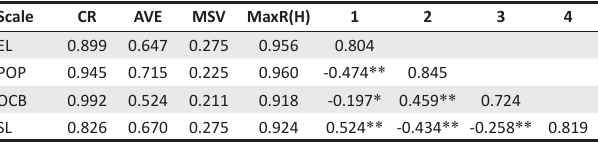
TABLE 4: Model validity